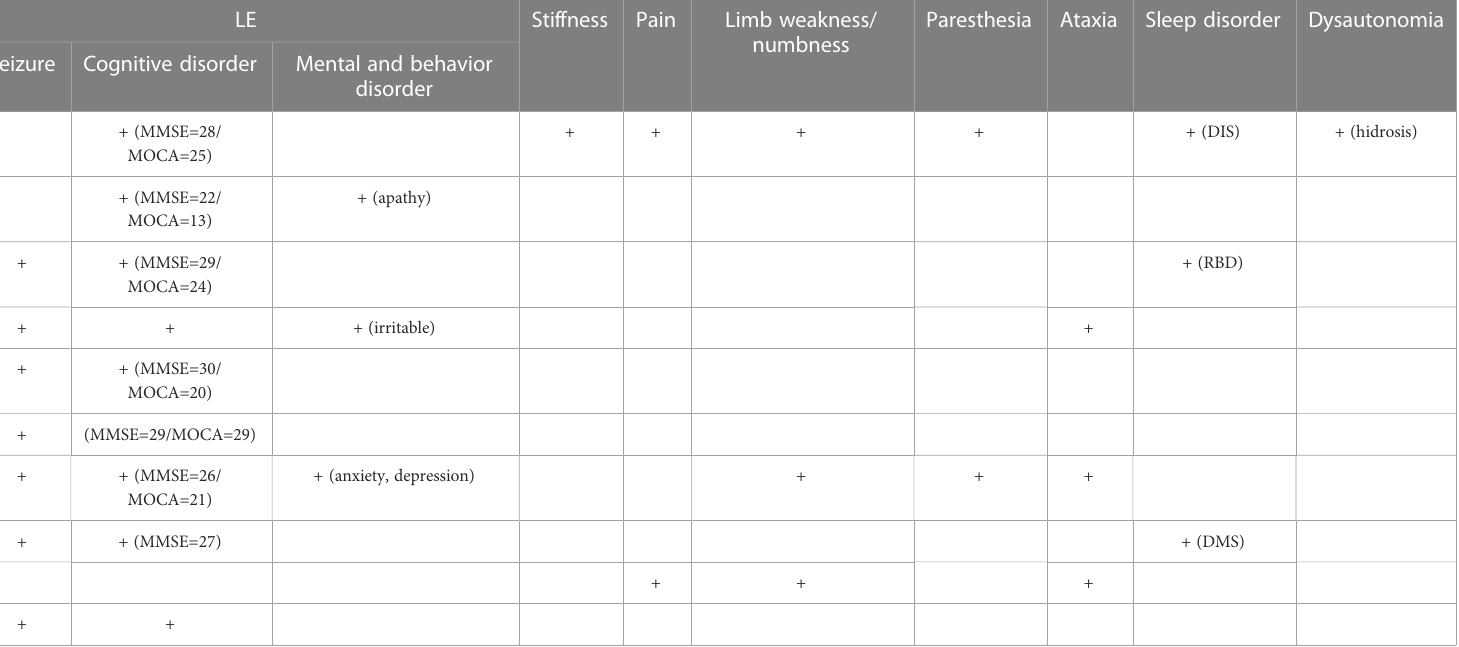
TABLE 1 Clinical manifestation of anti-amphiphysin